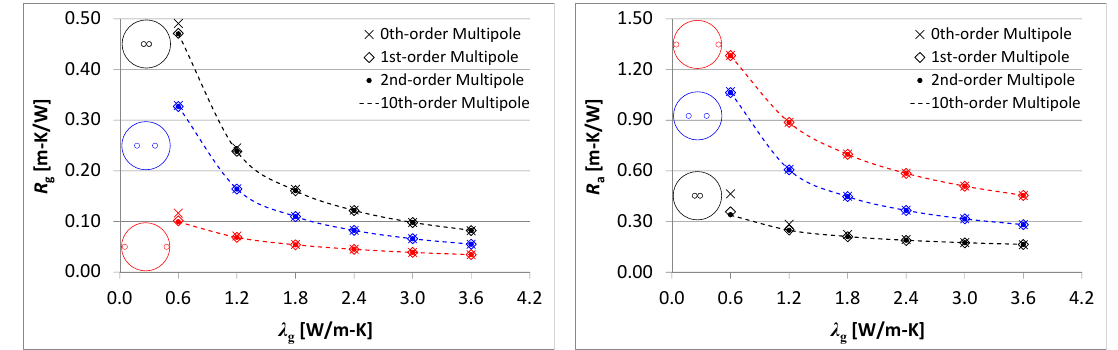
Figure 7. Grout thermal resistance ( R g ) and total internal resistance ( R a ) for close (2 x p = 32 mm), moderate (2 x p = 107 mm) and wide (2 x p = 256 mm) configurations with 2 r b = 288 mm and λ = 4 W/m-K.